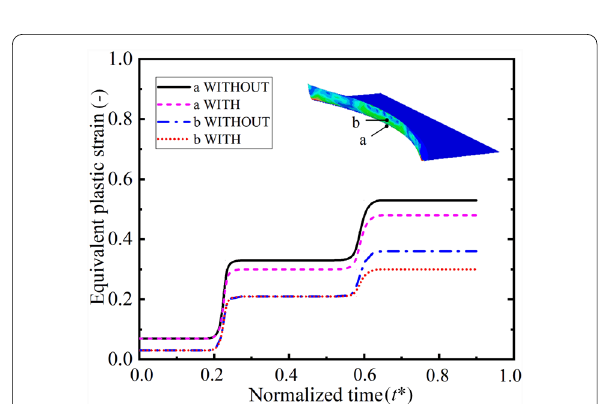
Figure 14 Evolution of equivalent plastic strain of samples with and without adhesive at different